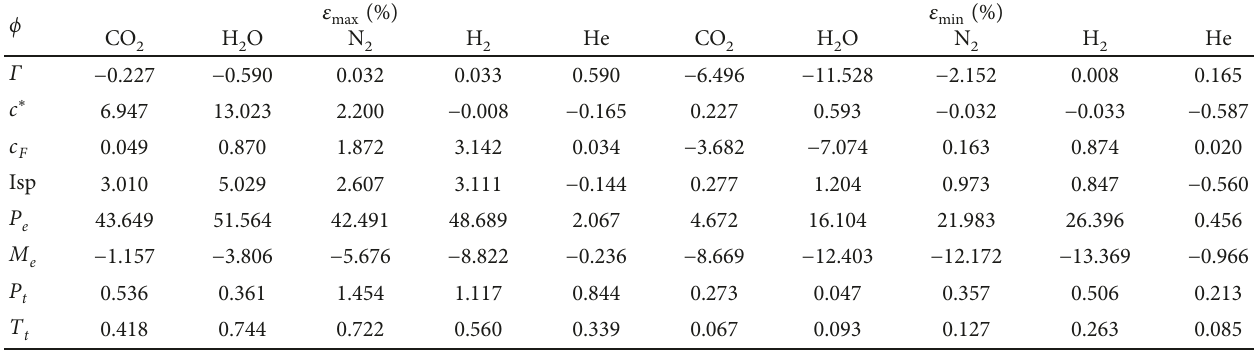
Table 3: Maximum and minimum error values of propulsion and fl ow parameters of calorically perfect ideal gases for P K – 4000K and frozen fl ow expansion in vacuum with A